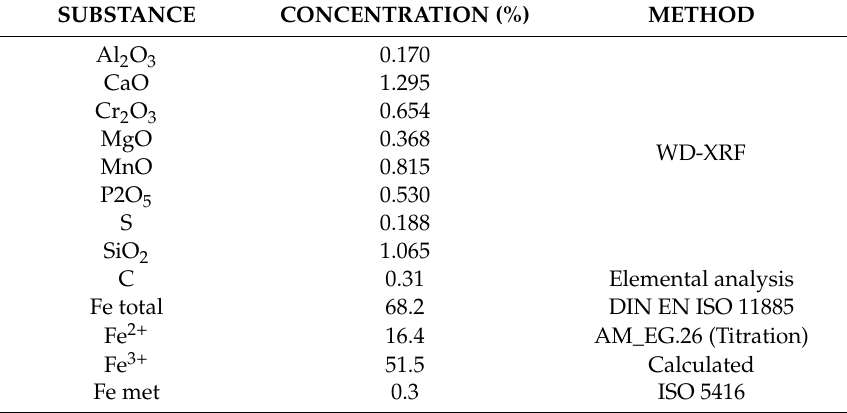
Figure 4. Picture ( a ) and stereo-micrography ( b ) of SIDENOR oxy-cutting fines samples. Table 4. Chemical analysis of SIDENOR oxy-cutting fines samples.